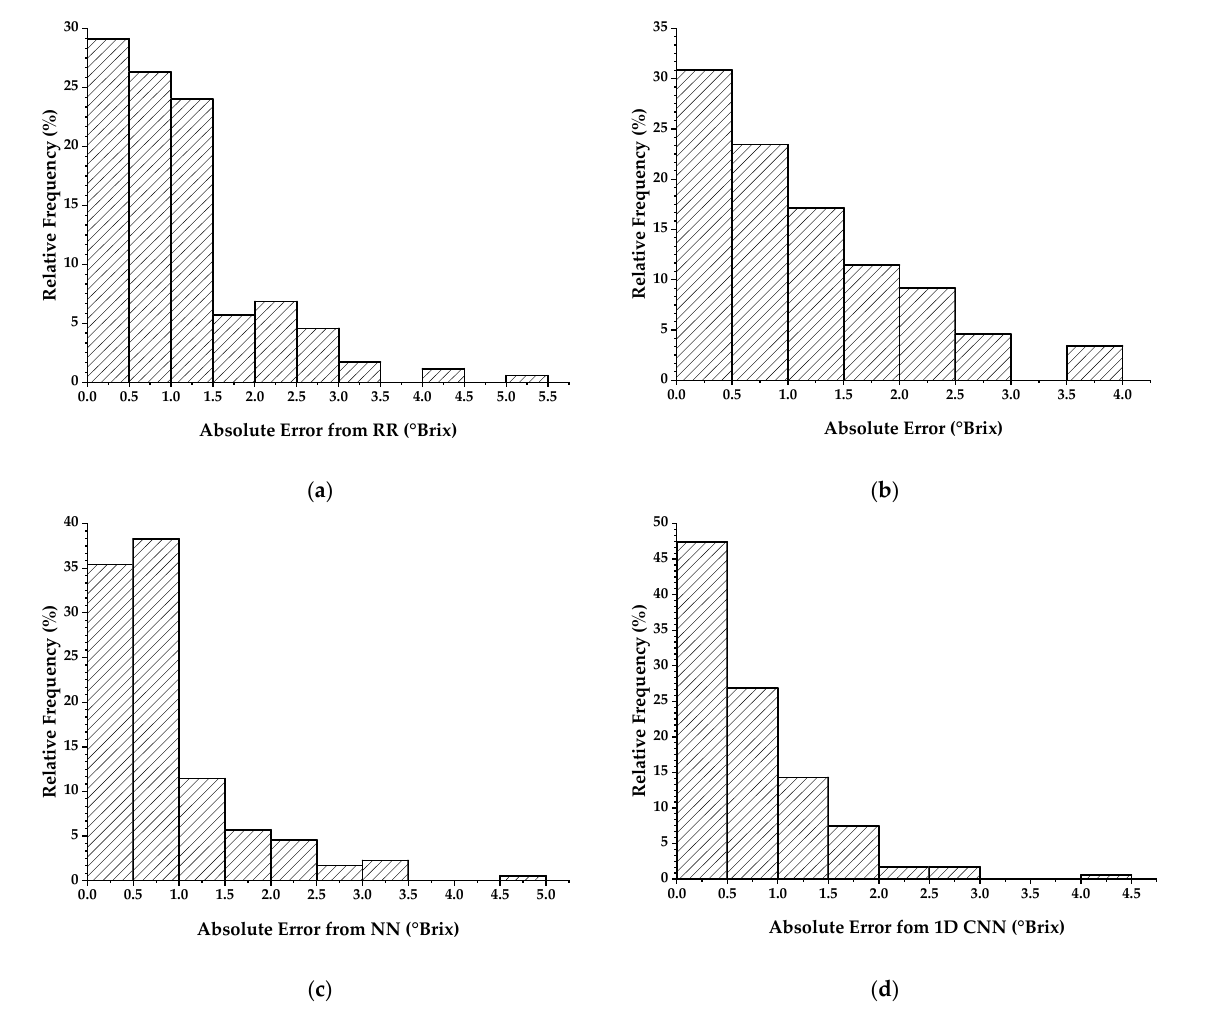
Figure 3. Histograms of absolute error for the TF independent test set: ( a ) ridge regression; ( b ) partial least squares; ( c ) neural network; ( d ) one-dimensional convolutional neural network. In order to evaluate if there are statistical differences between the absolute errors of predictions across each pair of methods, a paired t -test with a significance level of 0.05 was computed (see Table 5). Through the analysis of this table, it is possible to observe